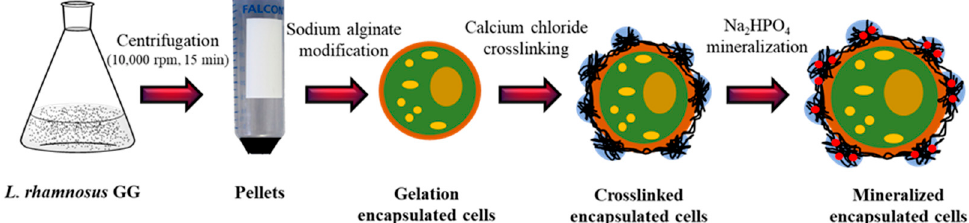
Figure 3. Schematic illustration of the encapsulation of L. rhamnosus GG: The L. rhamnosus GG cells obtained through centrifugation of broth were modified with a single layer of polyanionic sodium alginate (i.e., gelation), followed by the formation of a polycation layer by adding calcium chloride (i.e., crosslinking) and, finally, forming a layer of disodium hydrogen phosphate (i.e., mineralization).